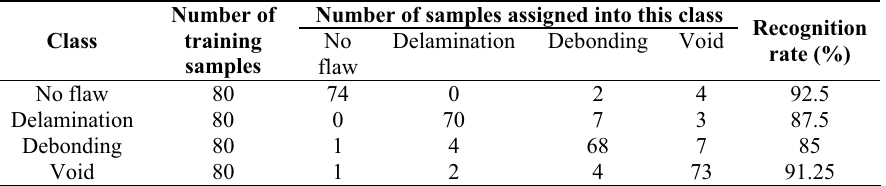
Table 8. Classification result using clustered_DWT based